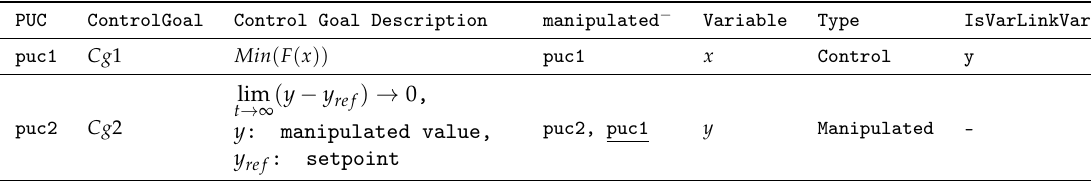
Table 8. EMS-template to detect conflict C I